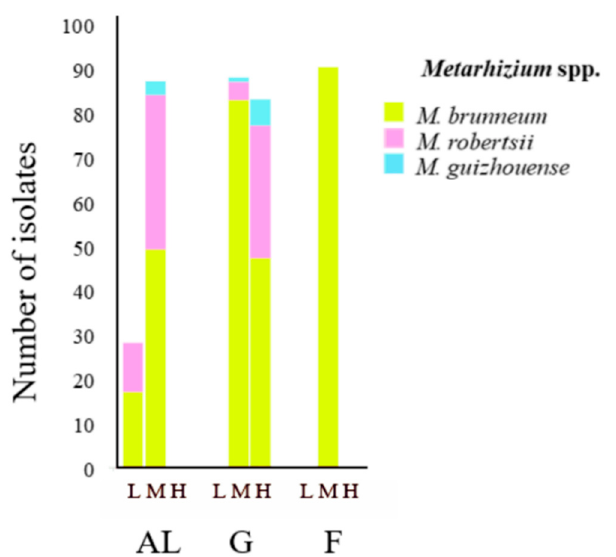
Figure 2. Number of isolates recovered for the three species identified ( M. brunneum , M. robertsii